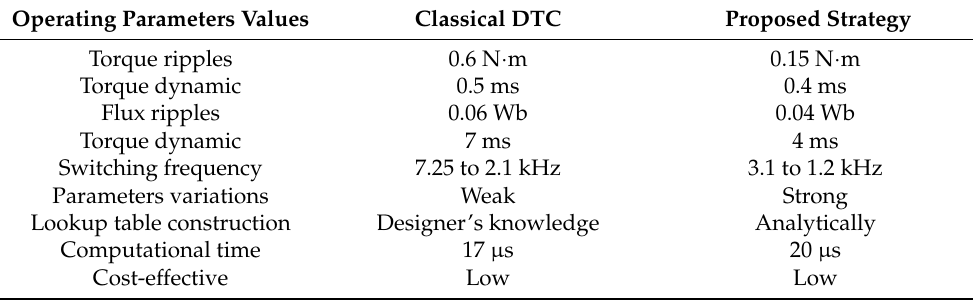
Table 3. Fair comparison between the improved and the classical